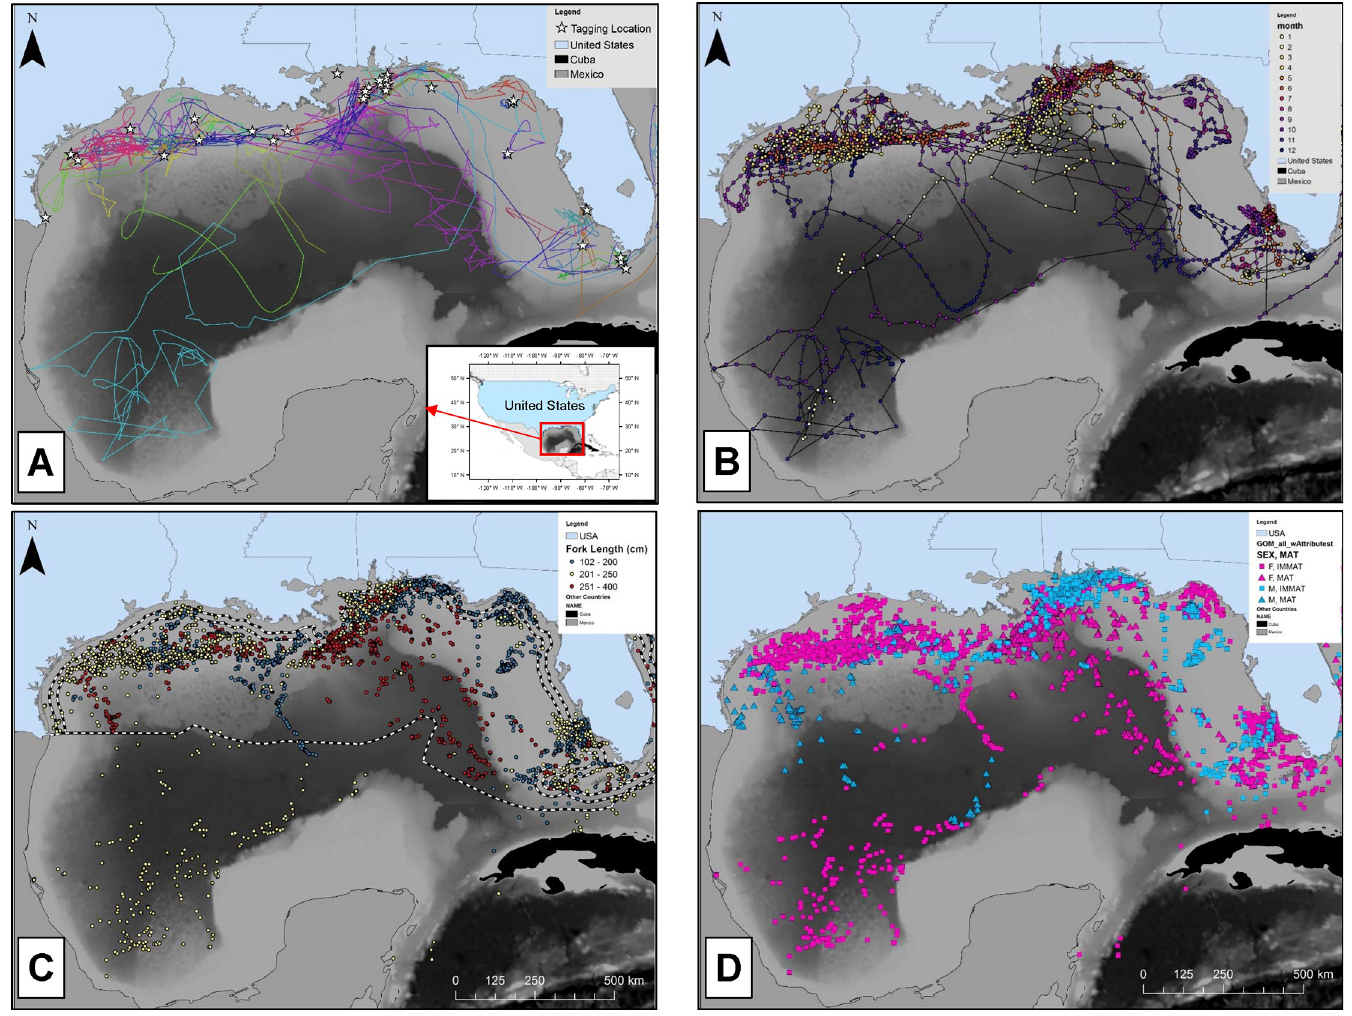
Fig 3. Maps of tiger shark tracks and distribution. A: Tag release locations (white stars) and individual tracks (colored lines) of tiger sharks fitted with SPOT transmitters from 2010 to 2018. Tracks are based on daily position estimates from the down-sampled data set. Inset map with red box delineates the Gulf of Mexico Large Marine Ecosystem. B: Tracks and positions displayed by month (color) to document seasonality of positions. C: Position estimates plotted by shark size (at time of tagging) category, small (100-200 cm FL, blue), medium (201-250 cm FL, yellow), and large (251-400 cm FL; red), and D: Position estimates based on maturity (squares = immature; triangles = mature) and sex (blue = males, pink =